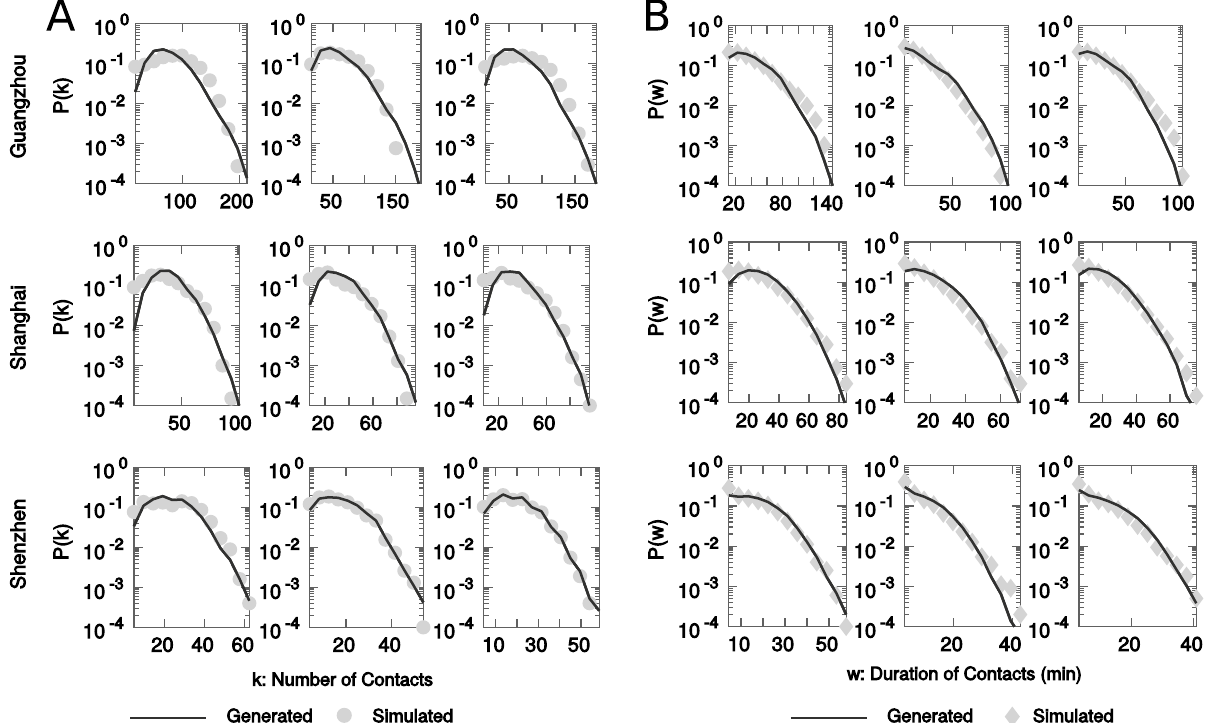
Figure 4. Visualization for the goodness of fit of the generated MCNs as compared to the simulated MCNs from the smart card data. Each row corresponds to the results of the same city and each column corresponds to the results from a particular time of the day. ( A ) Fitting results of the probability density function for the unweighted degree distributions. ( B ) Fitting results of the probability density function for the weighted degree distributions. All results are obtained from the average performance of 50 generated MCNs using the optimal γ t and from the average of 50 simulated MCNs. Each MCN has 1000 nodes. All scenarios fail to reject the null hypothesis of the KS test with very high p-values, where the summary statistics of the KS test and calibrated model parameters are shown in Table